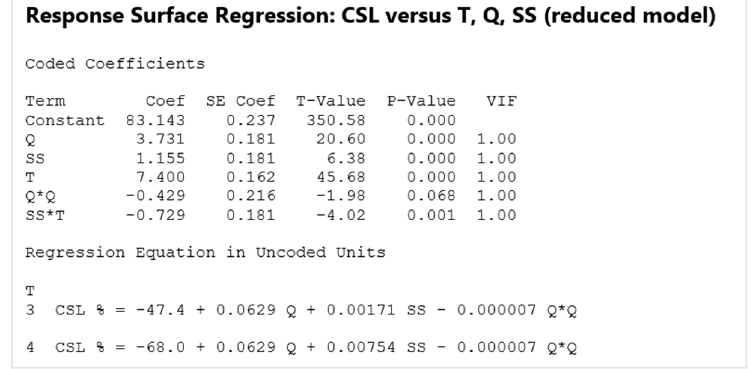
Figure 11. CCD—response surface regression of CSL (%) versus T, Q, and SS (reduced model).